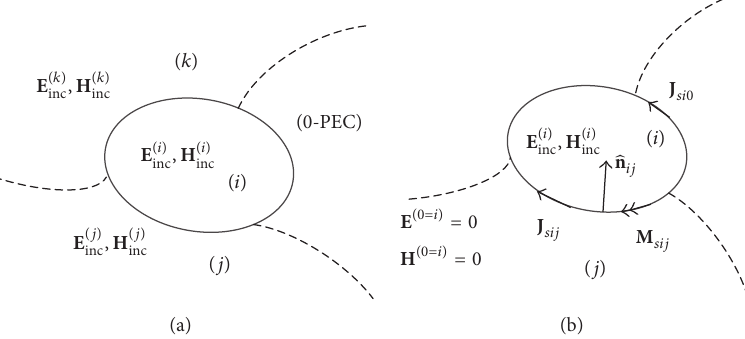
Figure 1: Surface equivalence theorem: (a) the original problem and (b) the equivalent problem for region 𝑖